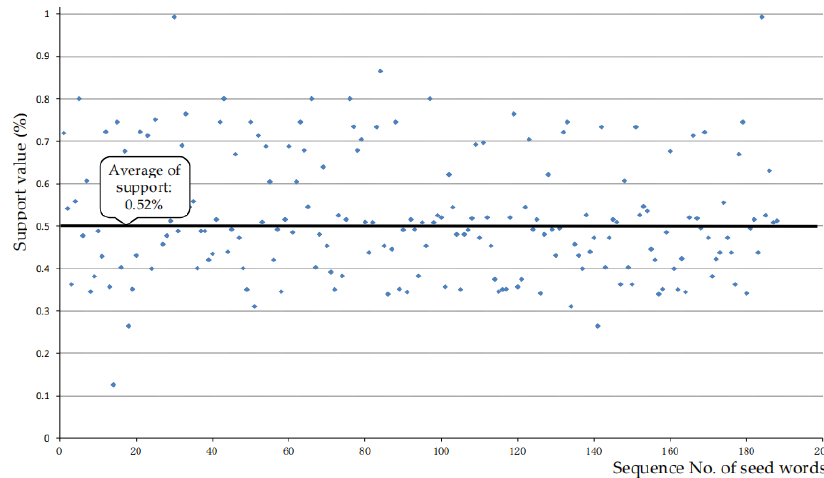
Figure 4. Support values of seed words at the lower end of the inflection